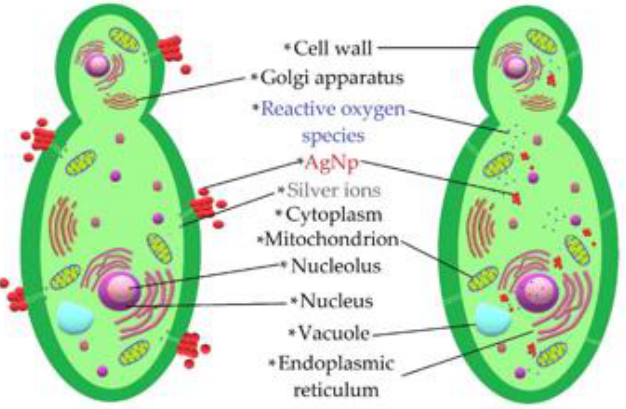
Figure 12. Schematic representation of the mechanisms employed by the AgNPs acting on